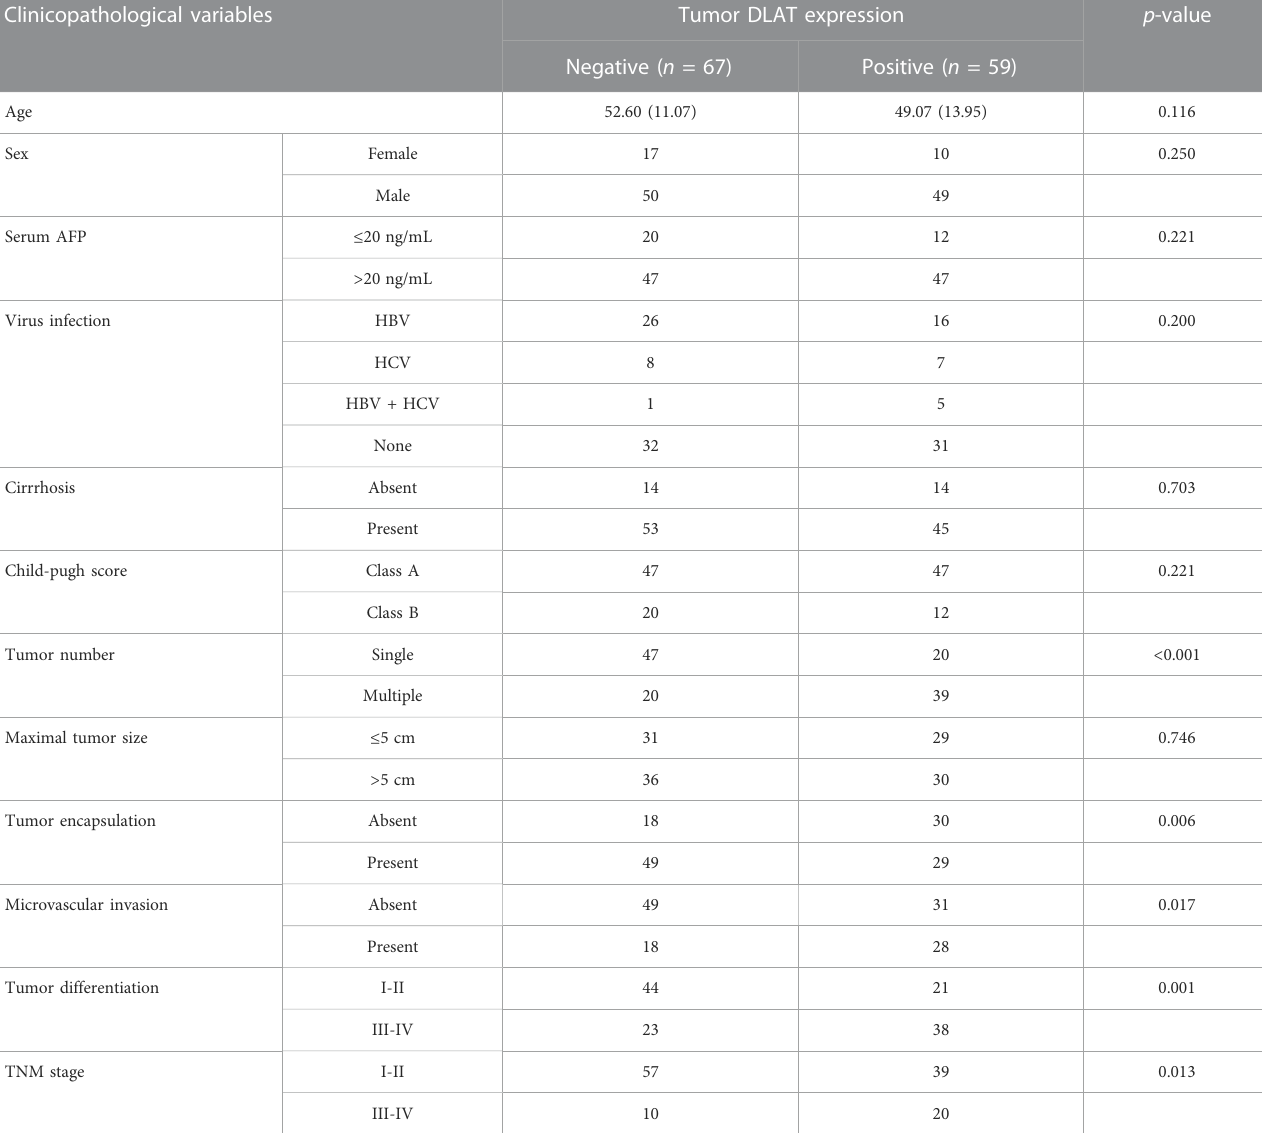
TABLE 1 Correlation between DLAT expression and clinicopathological characteristics of HCCs in cohorts of human HCC tissues. Clinicopathological